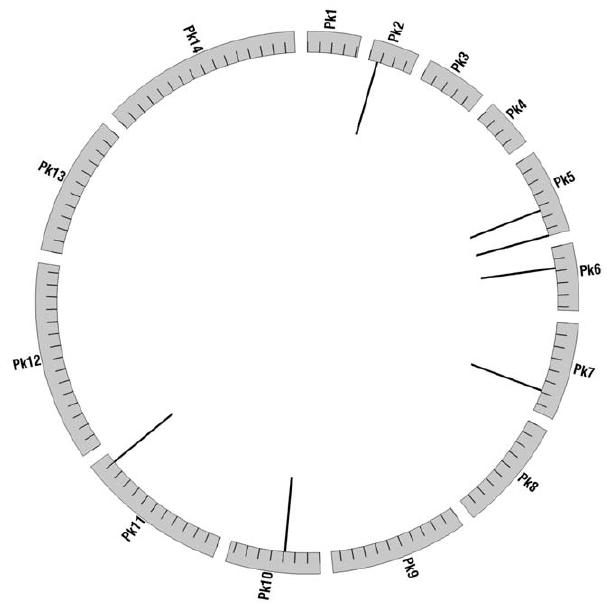
Figure 6. Spatial distribution of Pkr140 sequence targets across the 14 P.knowlesi genome. The circle represents chromo- somes. Each chromosome is labeled with the 2-letter genus and species abbreviation for P. knowlesi and the chromosome number. Tick marks indicate 1 mb of sequence. Lines inside the circle indicate the location of Pkr140 copies and are not to scale. Circos 0.51 (http://mkweb.bcgsc. ca/circos/) was used to generate this map [44].